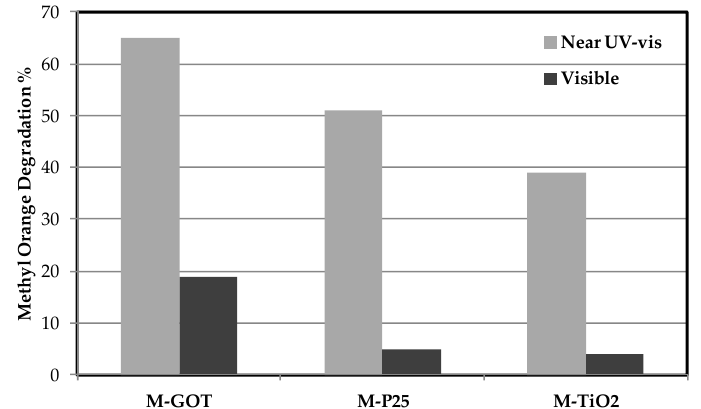
Figure 3. Photocatalytic degradation of Methyl Orange (MO) in distilled water (DW) in continuous mode under near UV–vis and visible light irradiation (data from Pastrana-Martìnez et al. [27]).